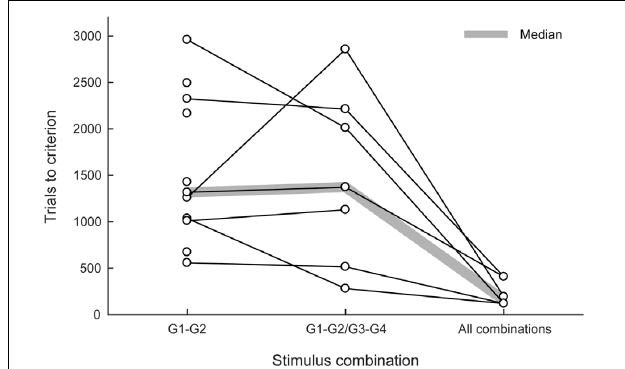
FIGURE 4 | Trials needed to meet the proficiency criteria in the delayed matching-to-sample task. The numbers of trials needed to meet the proficiency criteria in the third (left), fourth (center), and fifth phases (right) are summarized. G1, G2, G3, and G4 represent the graphic patterns used as stimuli. The thick shaded line indicates median values.